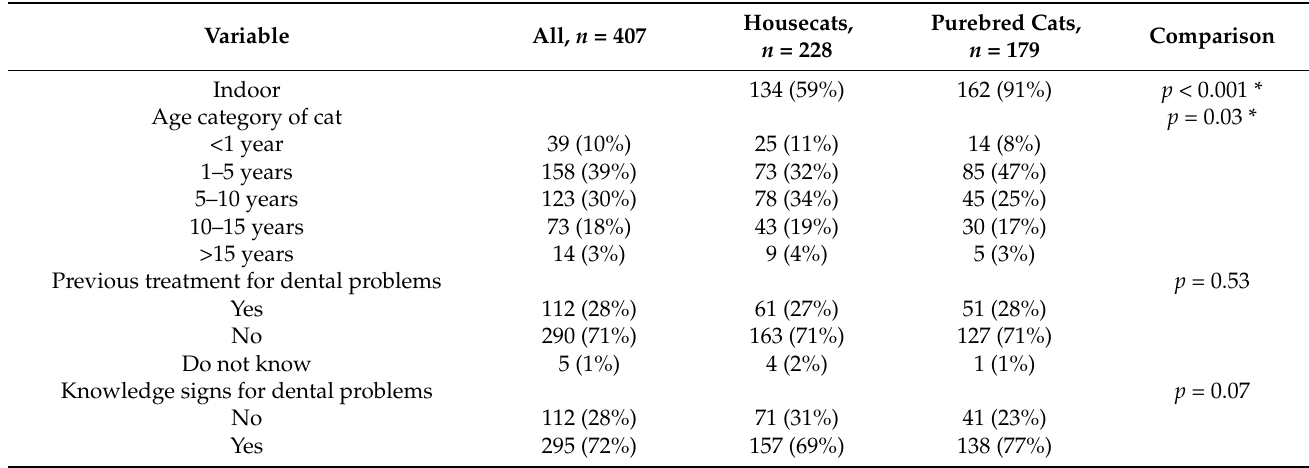
Table 1. Description of cat owners’ responses and characteristics from a survey to cat owners on knowledge of dental problems and prophylaxis. Comparison was made between housecat and purebred cat owners. For variables with >2 categories, the statistical test applies to the overall variable, not individual comparisons between categories. * indicates statistical significance.